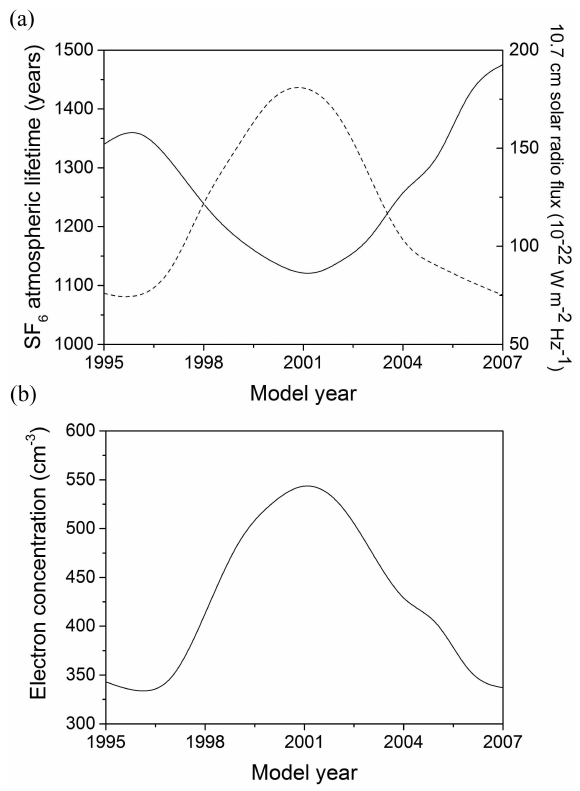
Figure 6. (a) Variation in atmospheric lifetime of SF 6 (solid line) and 10.7cm solar radio flux (dashed line) during the WACCM simu- lation. (b) Variation of the WACCM electron concentration (cm − 3 ) at 80km, averaged over polar latitudes (60–90 ◦ N and 60–90 ◦